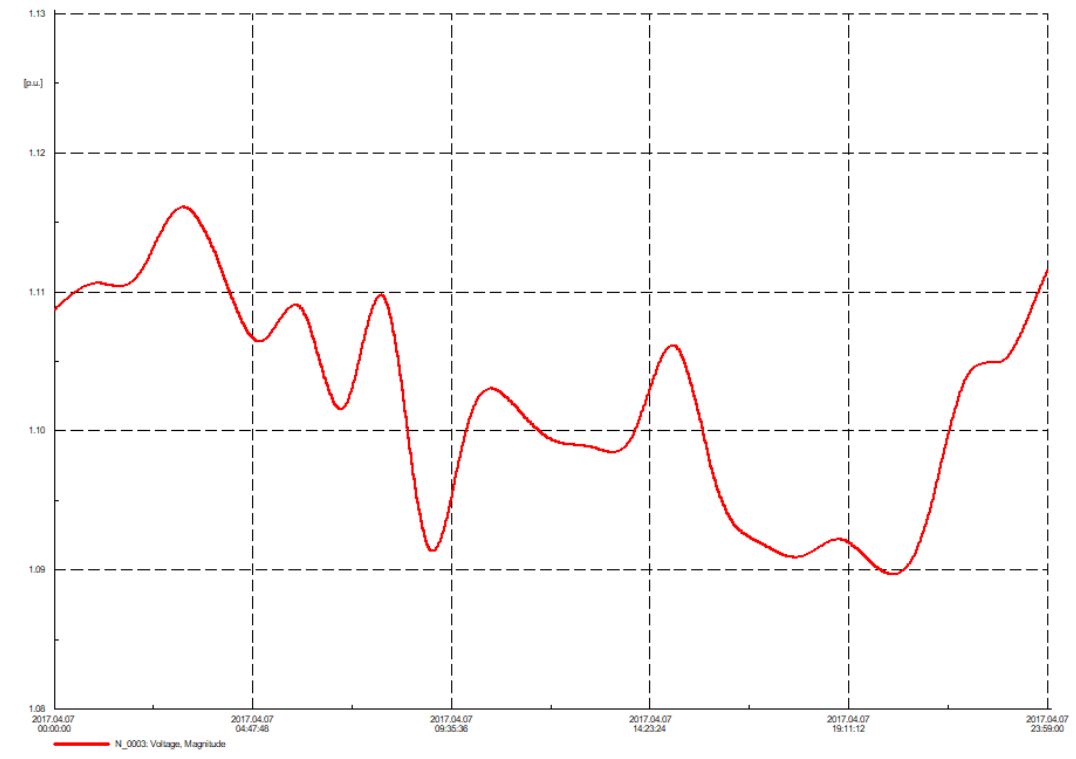
Figure 5. Voltage at bus 3 before addition of Static Synchronous Compensator (STATCOM).